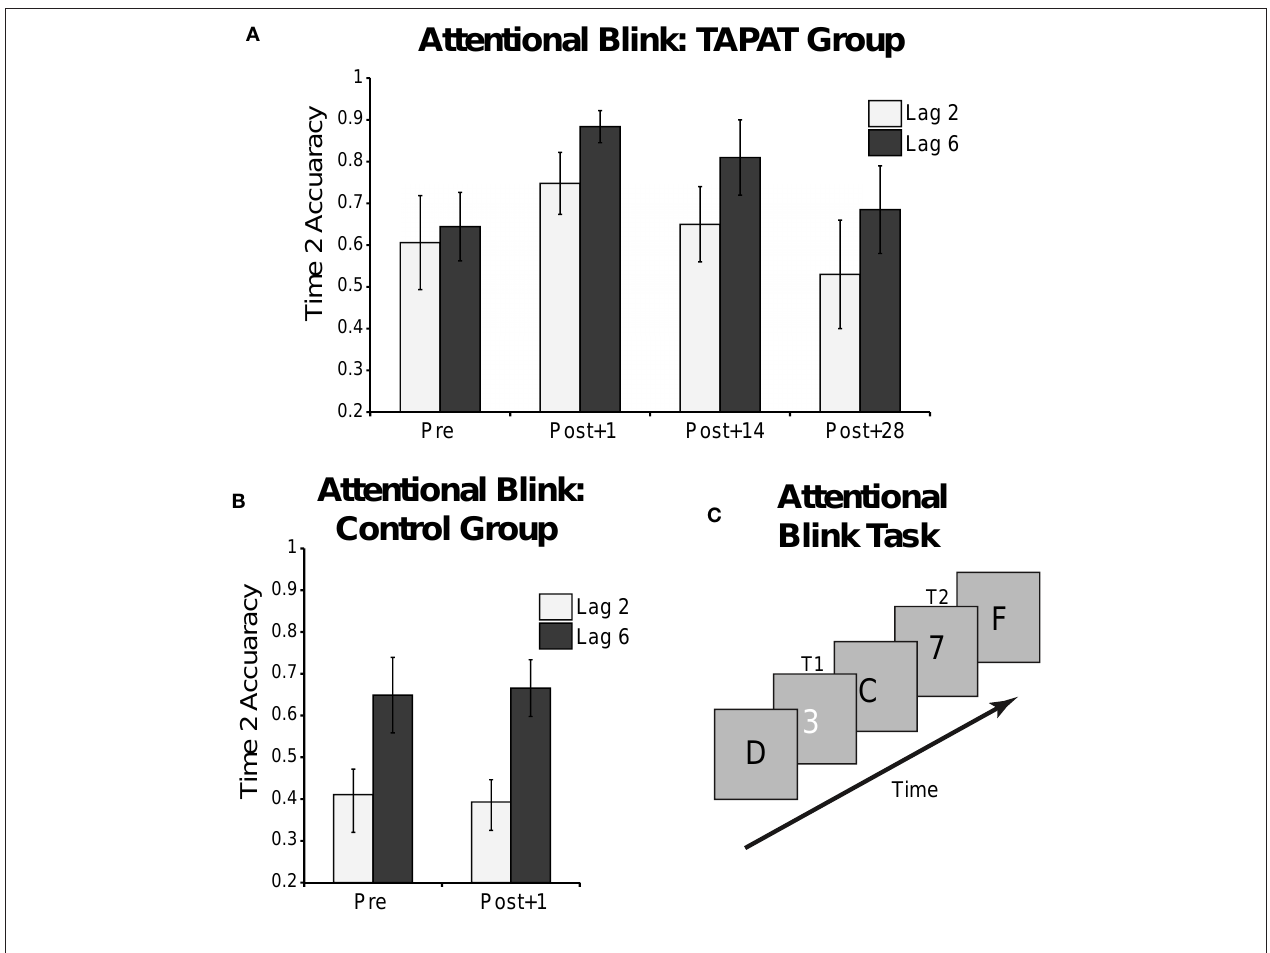
second target lags the first target by two positions (see example) or six positions. Error bars represent the standard error of the mean. (C) is an example of a lag 2 attentional blink trial: 3 is the first target (T1) and 7 is the